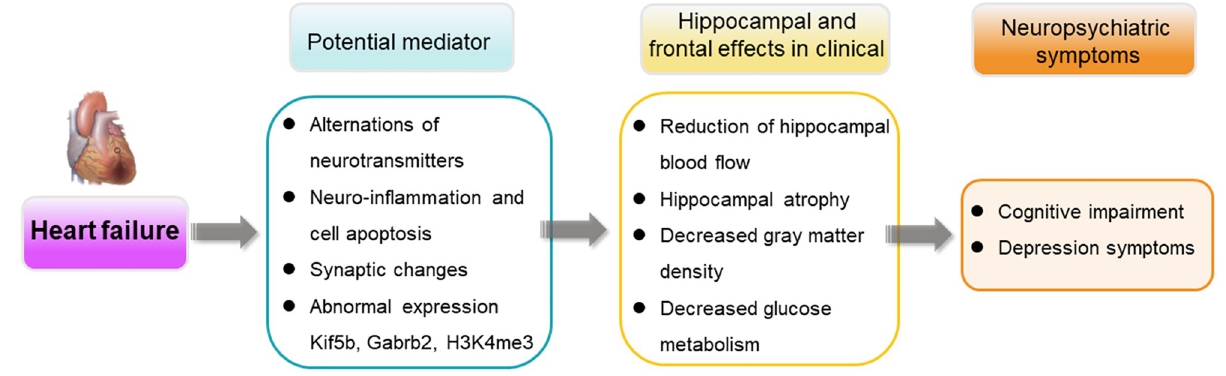
Fig 2. Graphical